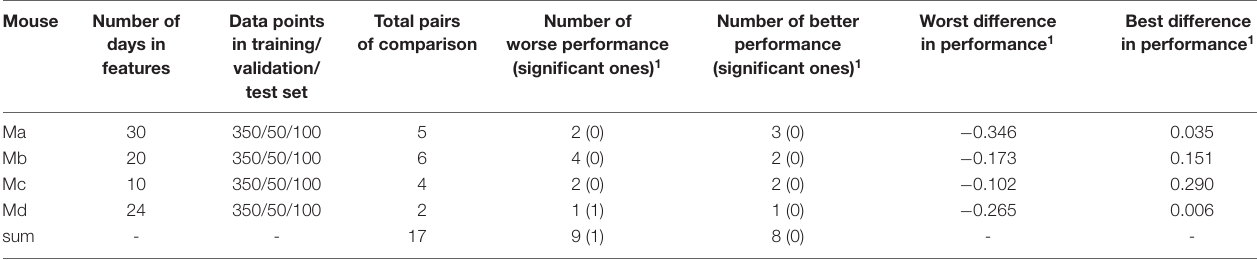
TABLE 5 | Summary of intra-location